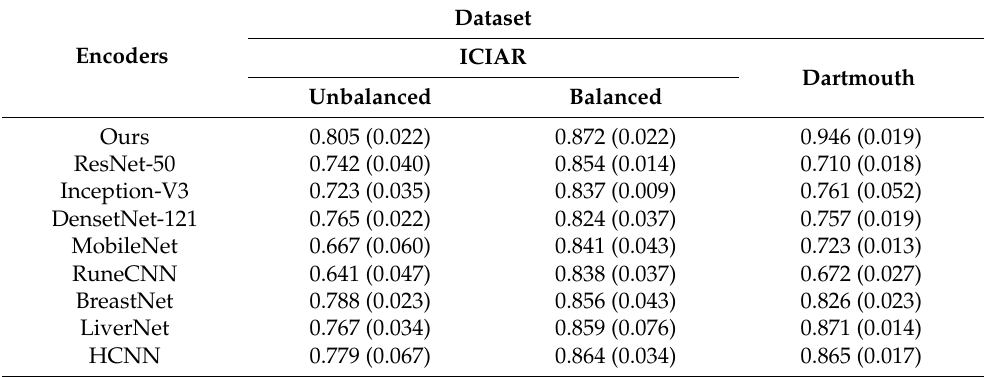
Table 7. Accuracy comparison of our encoder against literature encoders. The parenthesis values represent standard deviation.